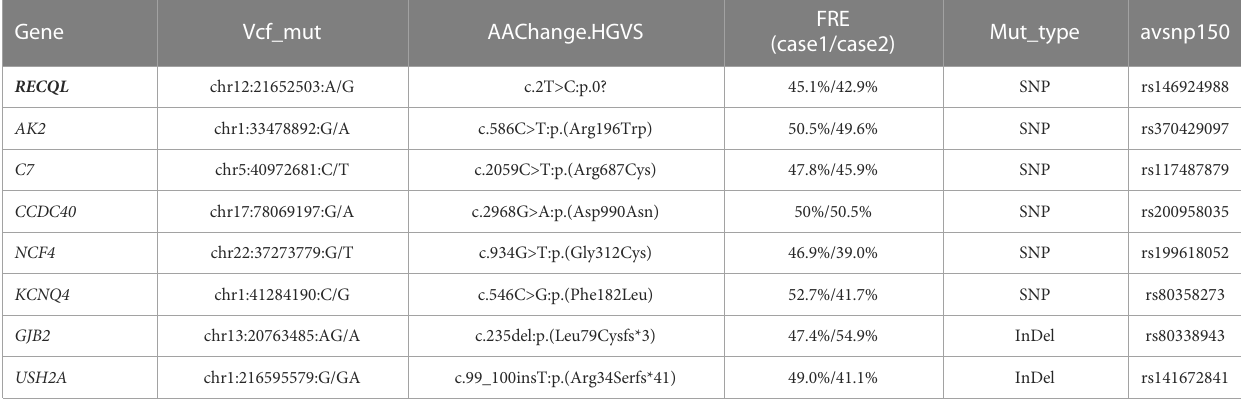
TABLE 1 Summary of shared germline gene mutations at remission